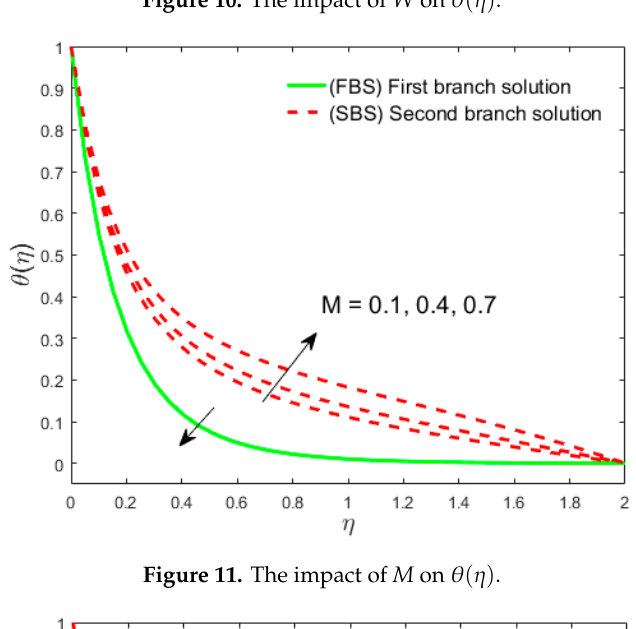
Figure 10. The impact of W on